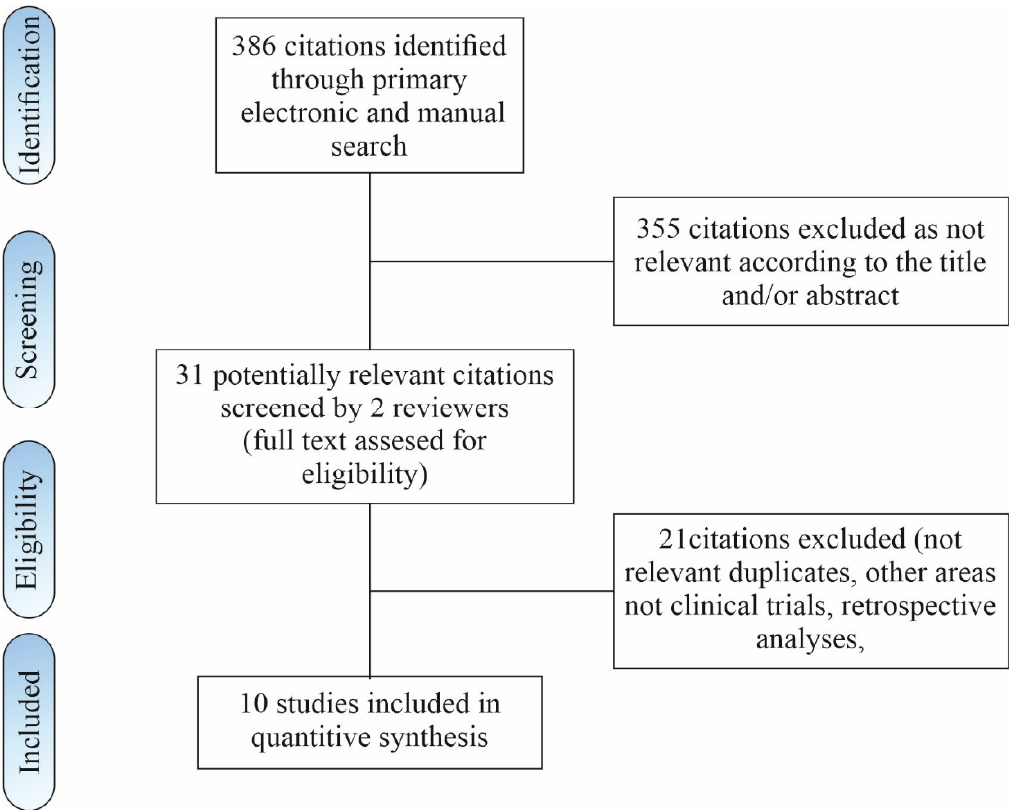
Figure 2. Flow chart of study inclusion.